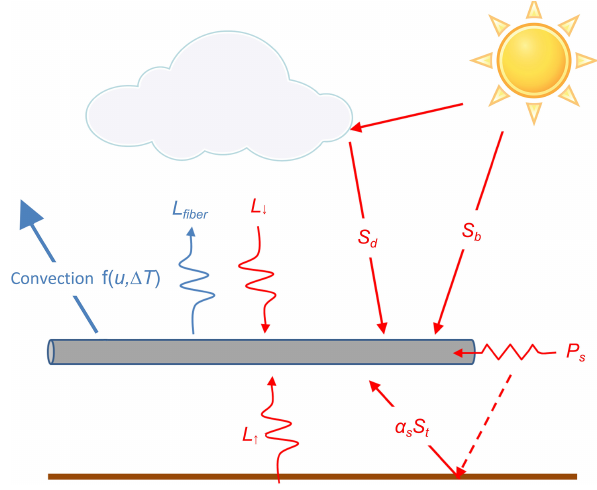
Figure 1. Schematization of the energy balance from Sayde et al.